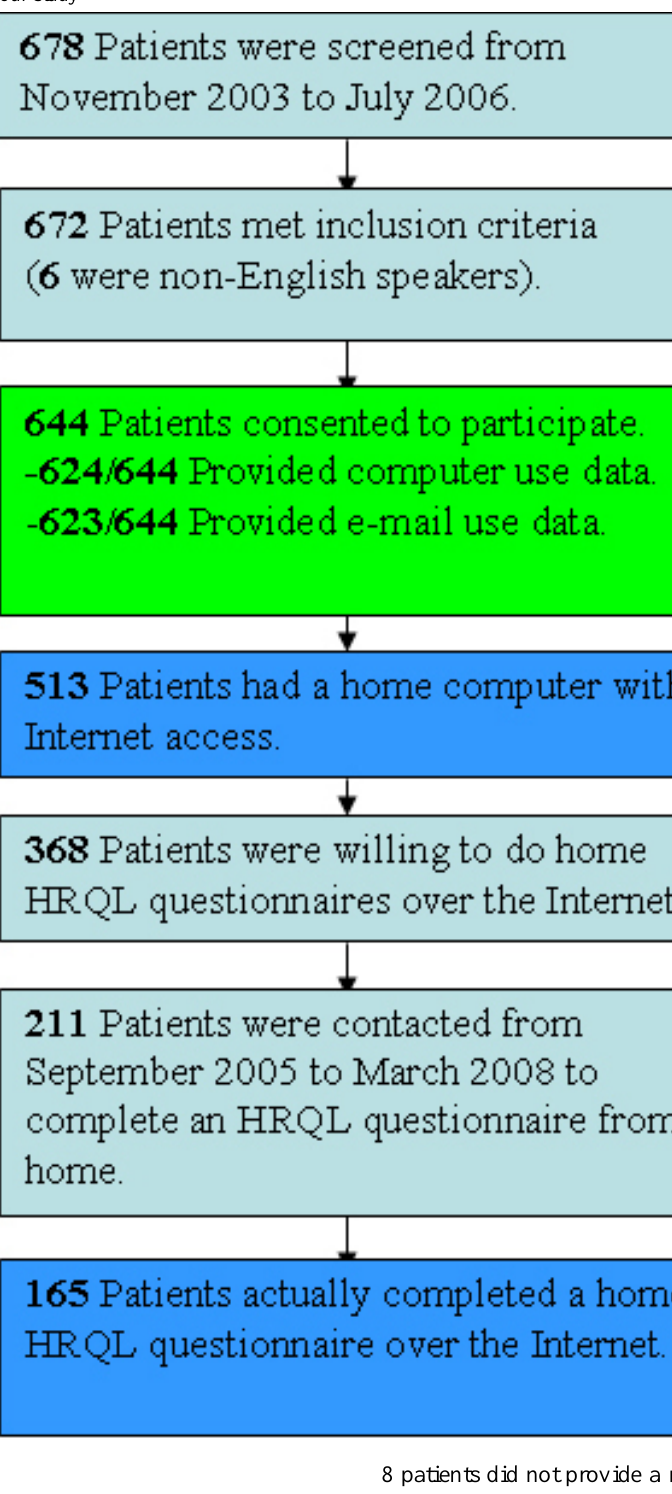
Figure 1. Patient flow through our